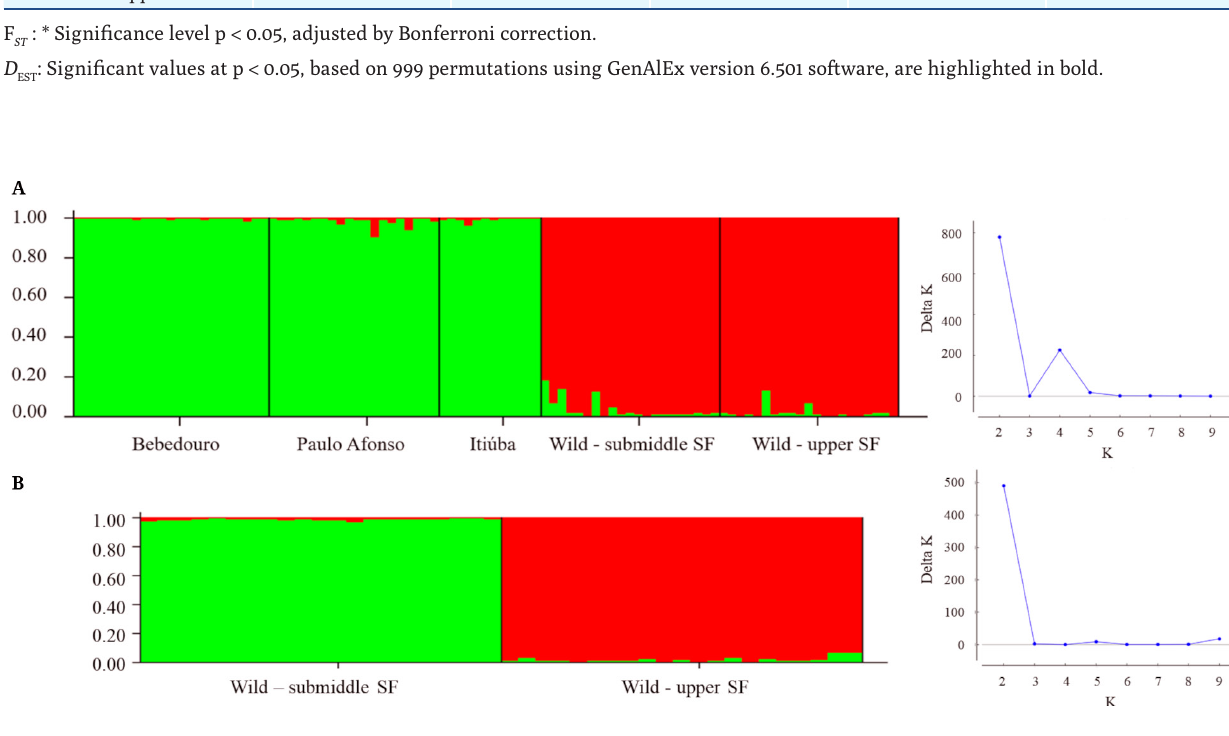
(below diagonal) and pairwise D ST